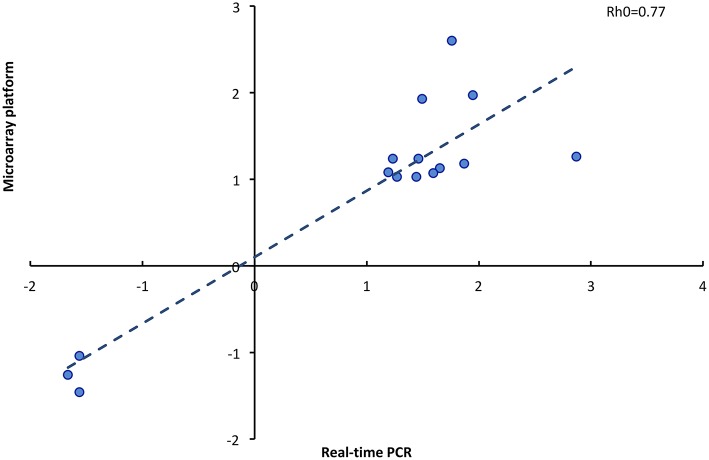
Correlation of fold change determined by microarray platform and real time PCR of 15 genes (Rho, Spearman coefficient).